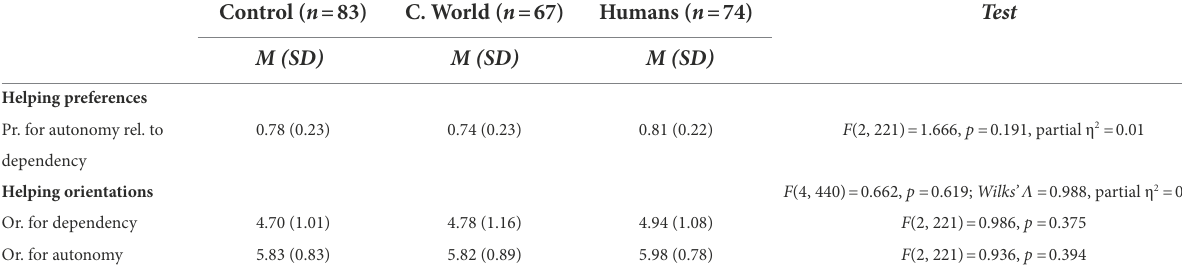
TABLE 4 Means, SD s and differences regarding the impact of the categories “citizens of the world” and